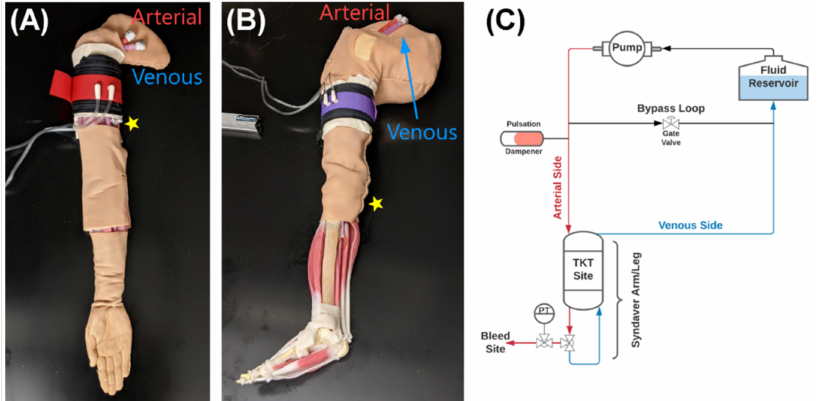
Figure 2. Overview of the human synthetic aTKT test platform. Synthetic ( A ) arm and ( B ) leg structures (SynDaver) served as the basis for testing the aTKT system as they have physiological and anatomical vasculature. Approximate aTKT position for each SynDaver model as well as arterial and venous tubing connections are shown. Approximate position of the bleed site is indicated by star label. ( C ) Flow diagram of the test platform. A reservoir filled with water supplied fluid to a cardiovascular-mimicking pump, which provided flow to either the arm/leg or a bypass loop that prevented over-pressurization when TKT was applied. Hemorrhage site was located at a valve in the arterial side of the arm/leg, and TKT was applied proximally to the hemorrhage site. A pressure transducer (labeled PT) was attached at the hemorrhage